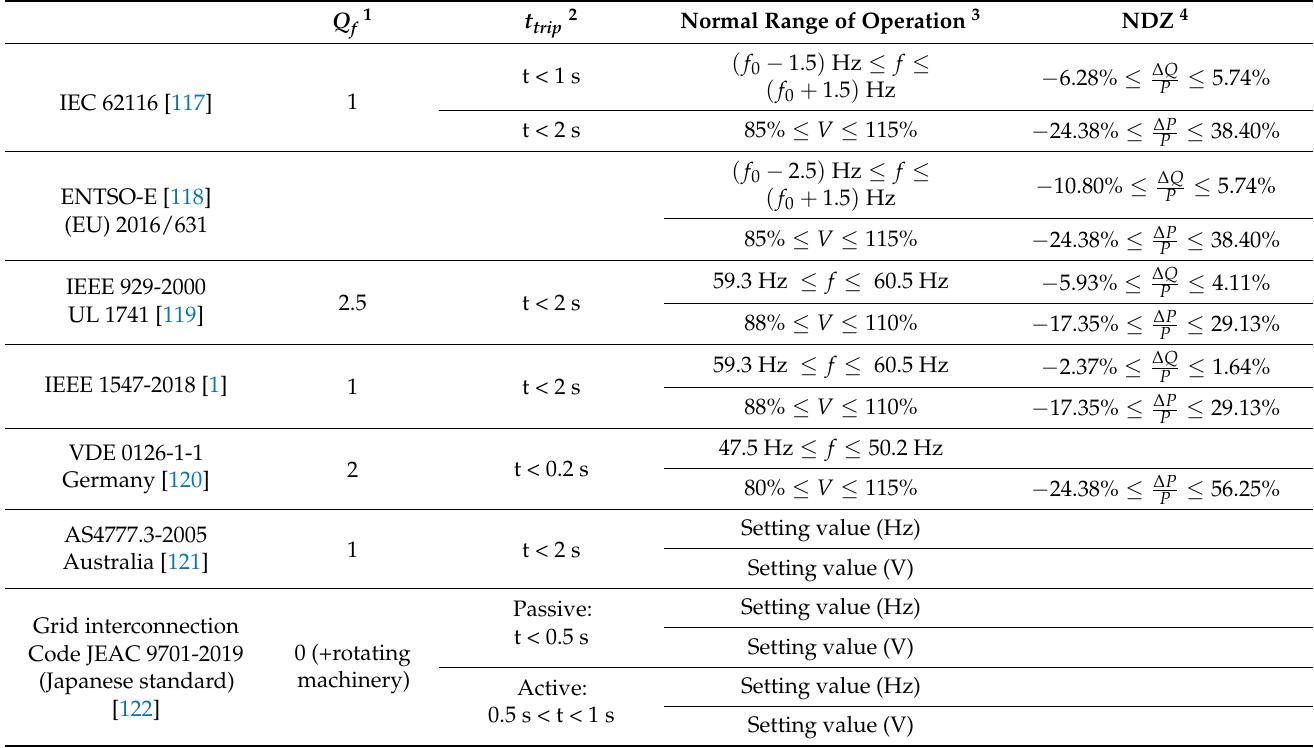
Figure 10. Experimental arrangement for the IEC 62116 test procedure [117]. Reprint with permission [IEC 62116 ed.2.0]; Copyright 2014, IEC Geneva, Switzerland. www.iec.ch. Table 6. Comparison between reference islanding standards and ENTSO-E [118]. Q f